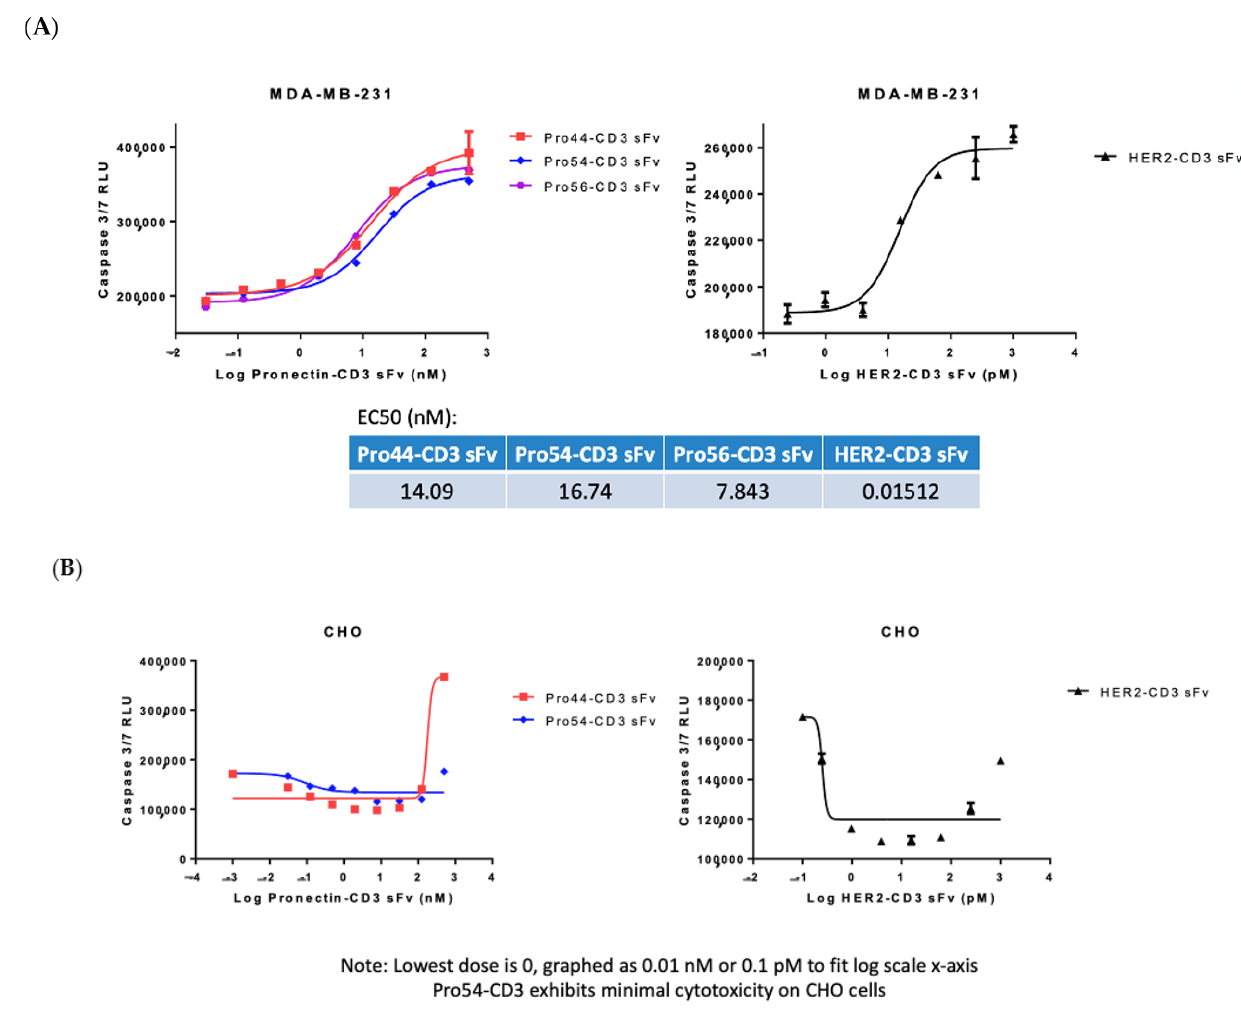
Figure 10. ( A ) Results from the Cytotoxicity Assay of three AXL-CD3 Pronectins on MDA-MB-231 cells. ( B ) Two AXL-CD3 Pronectins and the HERs-CD3 sFv control tested on the negative AXL expressing cell line CHO.